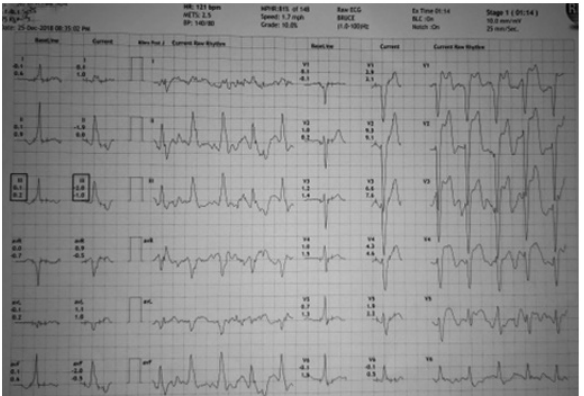
Figure 1: A) Electrocardiogram showing normal sinus rhythm with a baseline heart rate of 90 b/min. B) Electrocardiogram after 1 minute 14 seconds into Stage 1 of Bruce protocol, showing a complete Left Bundle Branch Block pattern at a heart rate of 121 b/min.